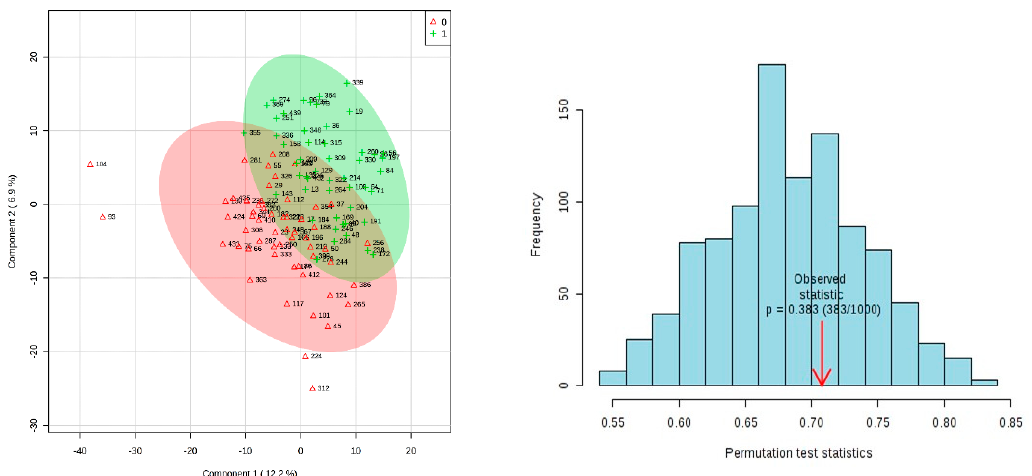
Figure 2. 2-D PLSDA Score Plot from 15-week GA dataset with results of 2000 times permutation. Cases are green, controls are red. PLS-DA model validation by permutation tests based on prediction accuracy. The p -value based on permutation is p = 0.383 (383 /